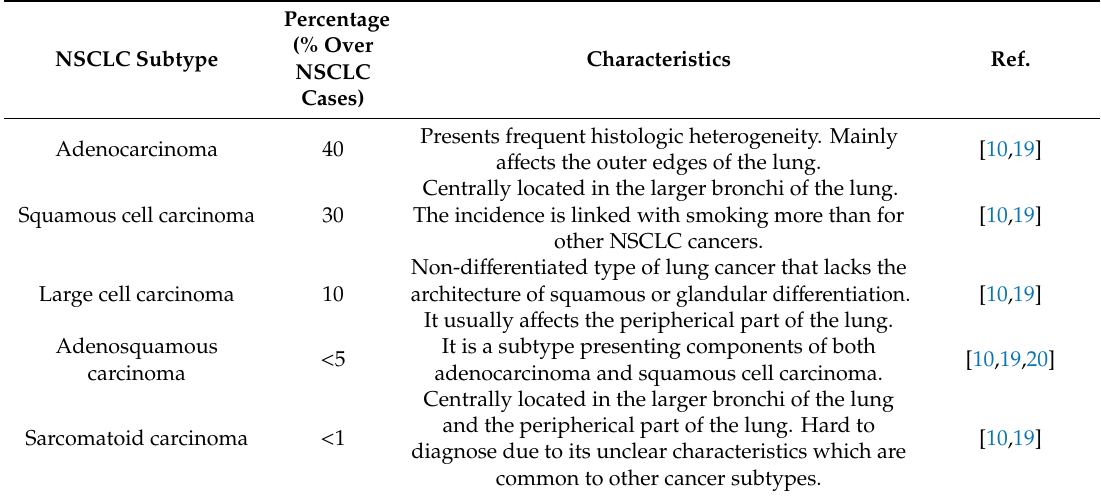
Table 2. Staging of NSCLC according to the International Association for the Study of Lung Cancer